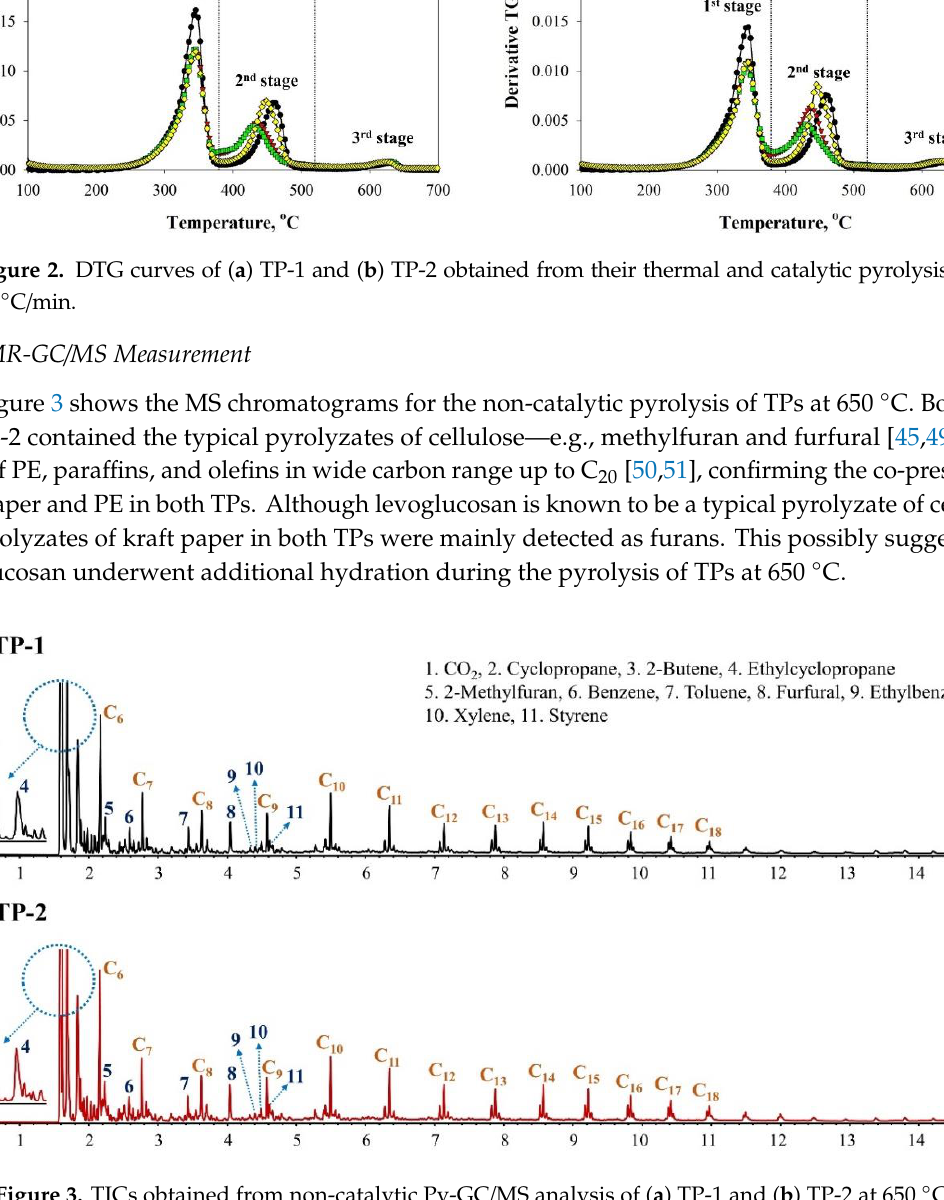
Figure 3. TICs obtained from non-catalytic Py-GC/MS analysis of ( a ) TP-1 and ( b ) TP-2 at 650 °C.